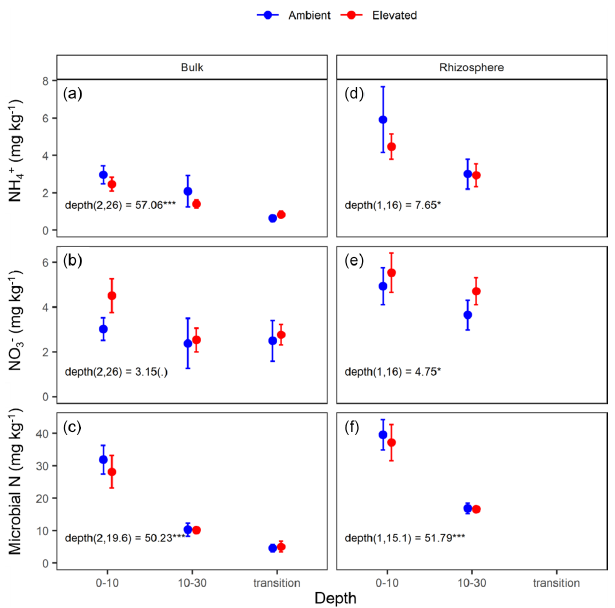
Figure 4. Nitrogen (N) pools in the forms of ammonium (NH + nitrate (NO − ), and microbial biomass N for the bulk and rhizo- 3 sphere soil of the mature Eucalyptus forest soil exposed to ambient (blue) and elevated (red) CO 2 for three depths (0–10 and 10–30cm and transition). Error bars indicate standard error. The mixed-effects model output is stated (degrees of freedom and Df residuals) and the F statistic presented. Asterisks for the P values for significance are as indicated, where ∗∗∗ indicate P< 0 . 001, ∗∗ indicate P< 0 . 01, ∗ indicates P< 0 . 05, and (.) indicates a tendency to a significance P< 0 . 1. Results from the statistical analysis of comparison of soil types (bulk and rhizosphere) are presented in Table